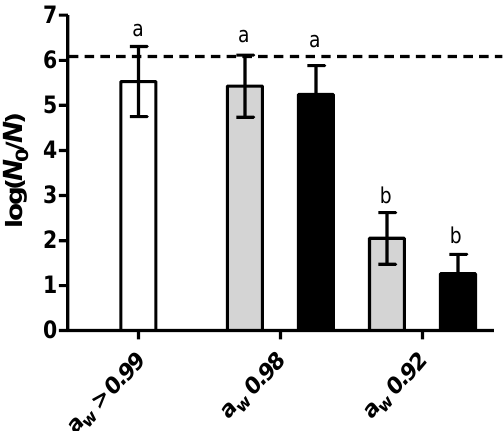
Figure 1. Logarithmic reduction factor (LRF; log( N 0 / N )) of L. monocytogenes Scott A by heat treatment (60 °C, 5 min) in sodium phosphate buffer (pH 6.7) at a w > 0.99 (control, white bars), 0.98 or 0.92, adjusted with glycerol (gray bars) or NaCl (black bars). Error bars represent the standard deviation of the means of triplicates. Different letters indicate statistically significant differences ( p ≤ 0.05) in the inactivation at different a w levels and using different solutes. The dashed line indicates the LRF corresponding to the quantification limit of surviving cells (1000 CFU/mL).